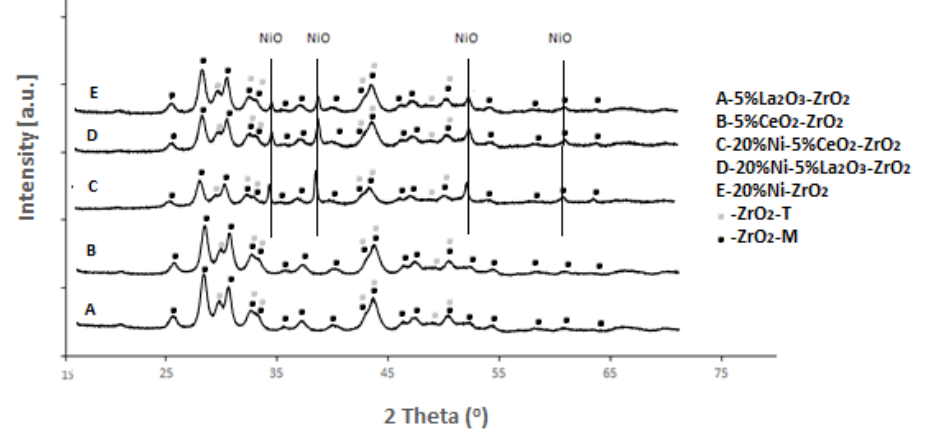
Figure 10. XRD curves of supports 5%La 2 O 3 -ZrO 2 , 5%CeO 2 -ZrO 2 , and monometallic Ni catalysts